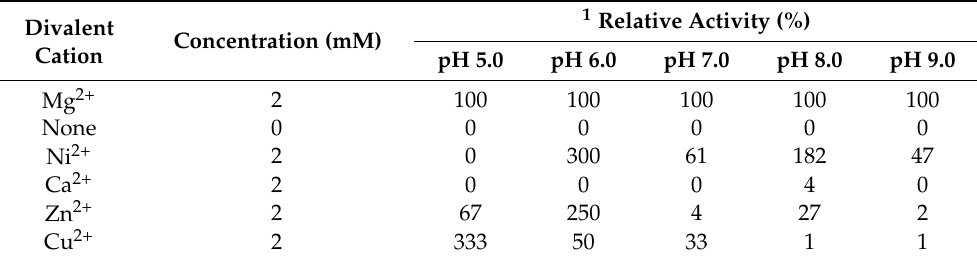
Table 1. Influence of divalent cations on the activity of KpNNAT at different pH.